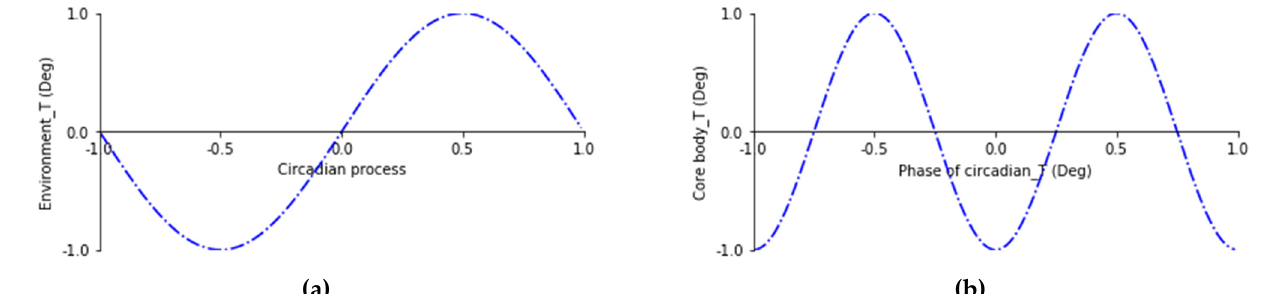
Figure 1. Representation of the circadian rhythm: ( a ) circadian process oscillation, ( b ) temperature (°C) process oscillation between the circadian temperature (horizontal axis) and the body temperature (vertical axis). Note: This is a normalized rhythm, although not all rhythms are identical. Our core body temperature is roughly linked to this cycle, with various hormones released at specific stages in the rhythm because our energy levels are reflected in our body temperature.